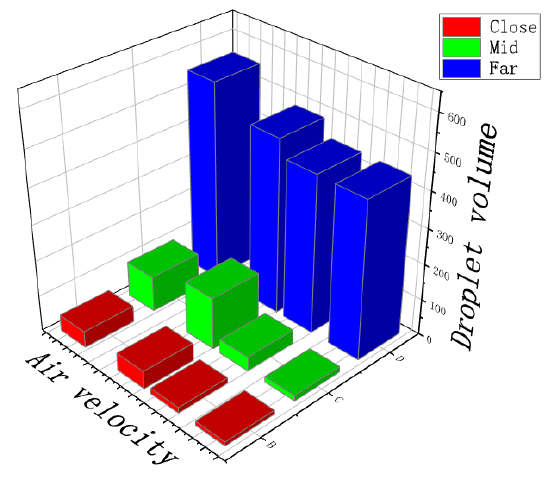
Figure 13. The canopy droplet deposition retention under different airflow velocity.